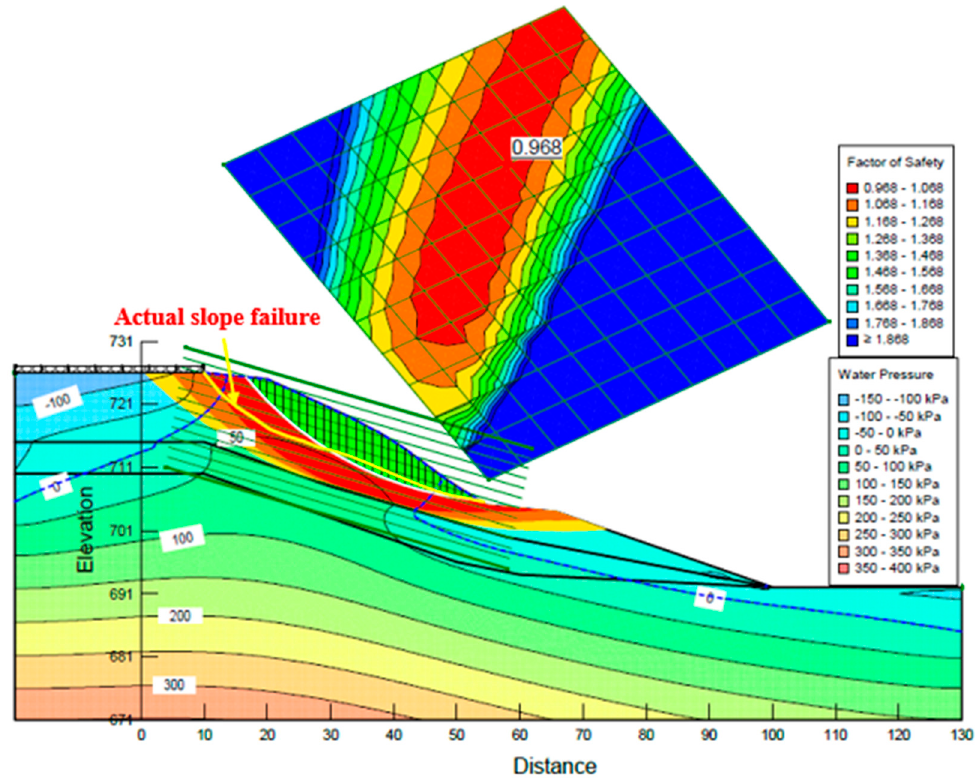
Figure 16. Slope failure after 4.5 h with a flux of 144 mm/day with overtopping.